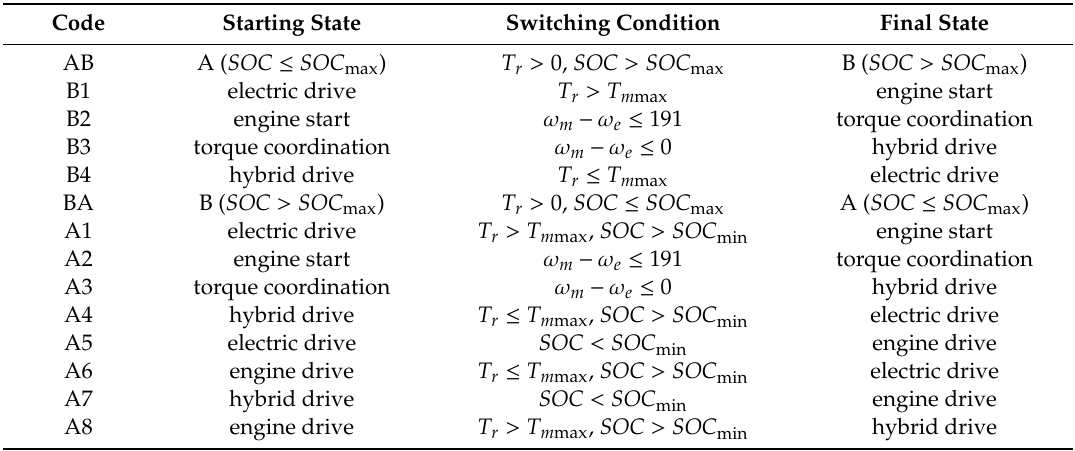
Table 4. The operating state and switching conditions of the rule-based control strategy with the torque